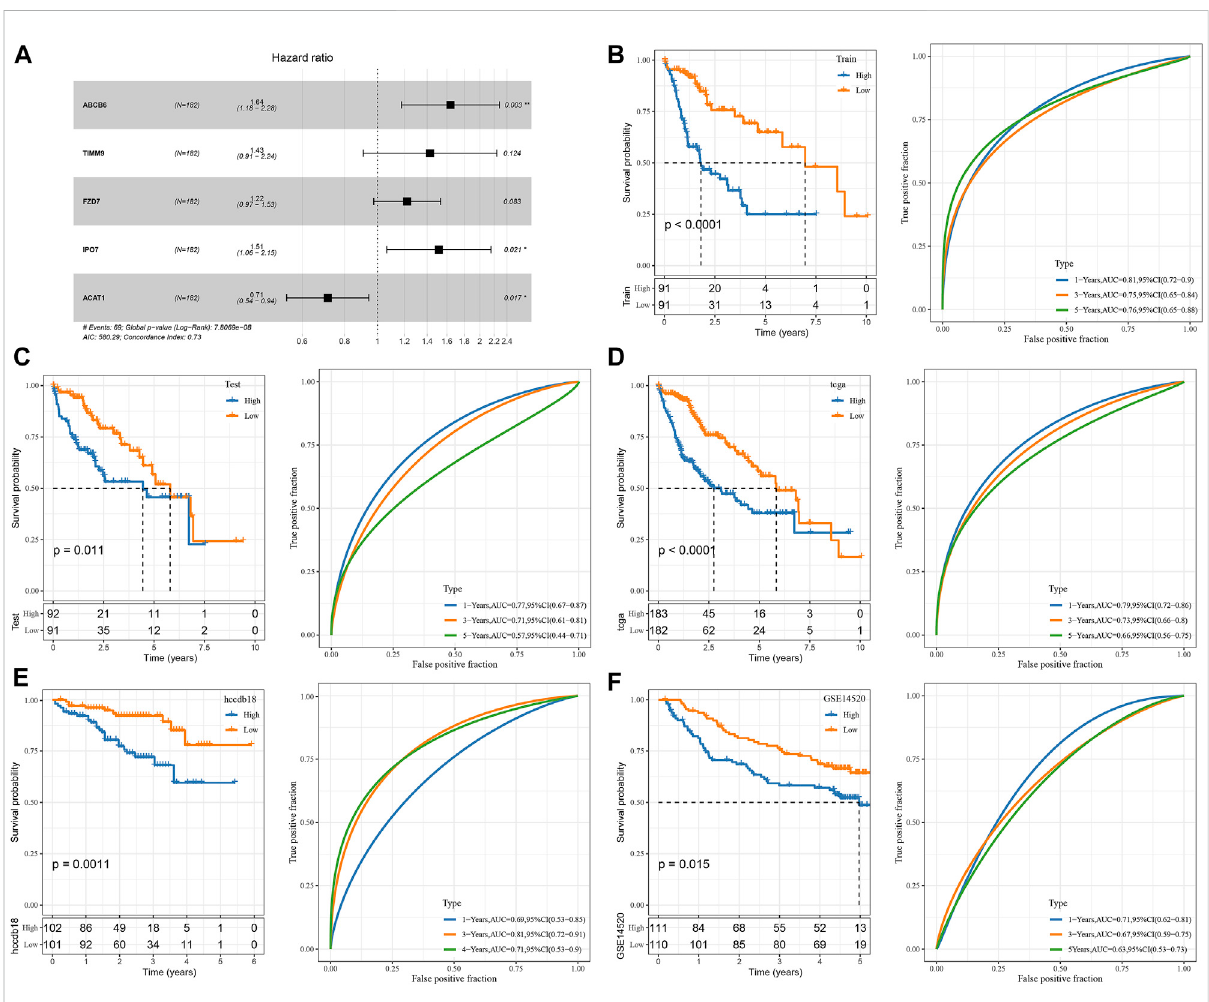
FIGURE 4 Construction and validation of the clinical prognostic model. (A) Multivariate Cox forest map of model genes; (B) ROC curve and KM survival curve of RS in TCGA training data cohort; (C) ROC curve and KM survival curve of RS in the TCGA validation data cohort; (D) ROC curve and KM survival curve of RS in TCGA cohort; (E) ROC curve and KM survival curve of RS in HCCDB18 cohort; (F) ROC curve and KM survival curve of RS in GSE14520